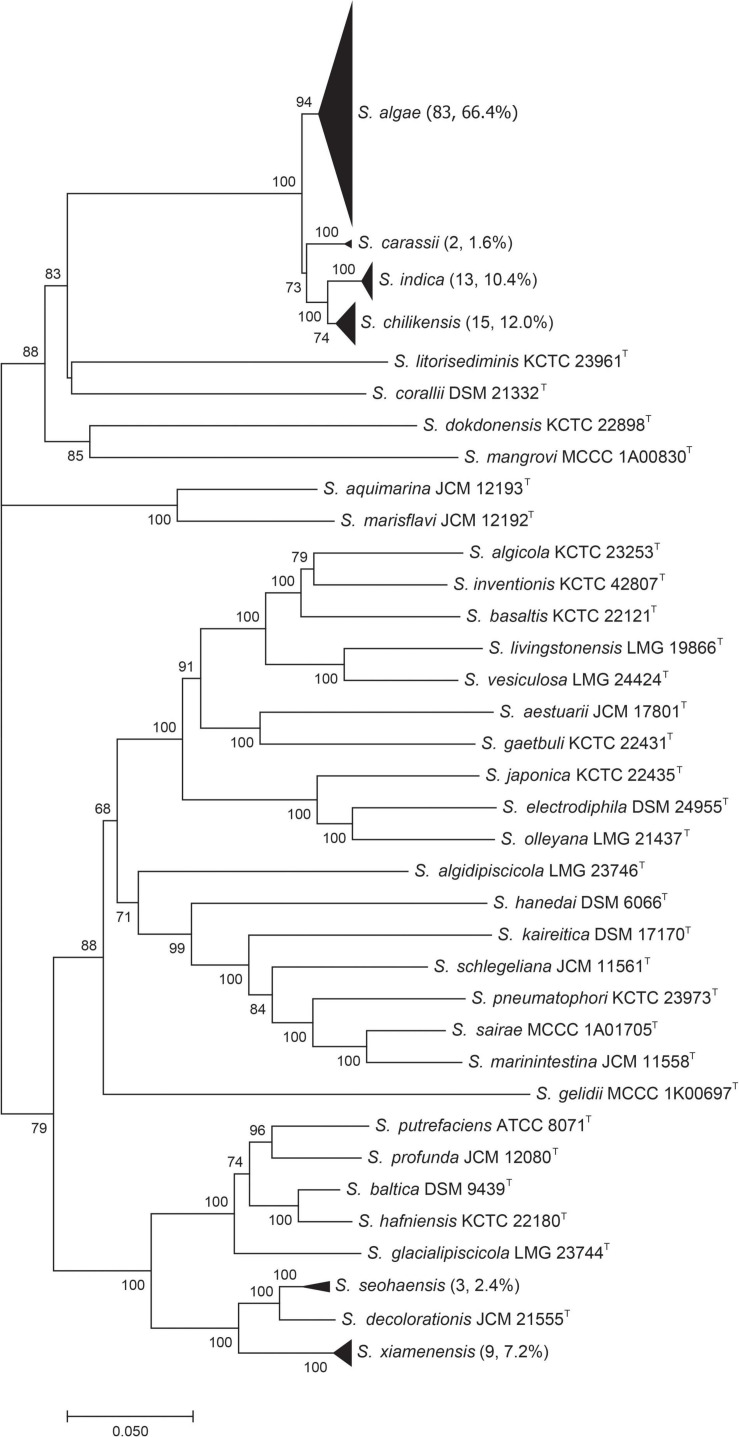
Phylogenetic tree constructed based on six concatenated gene sequences [gyrA, gyrB, infB, recN, rpoA, and topA (4,191 bp)] of 36 Shewanella type strains and 125 test strains (by the neighbor-joining method). Each black triangle contains the test strains of the same species, and the number of test strains is shown in brackets. Numbers on branches are bootstrap values in percentage from 1000 replicates.